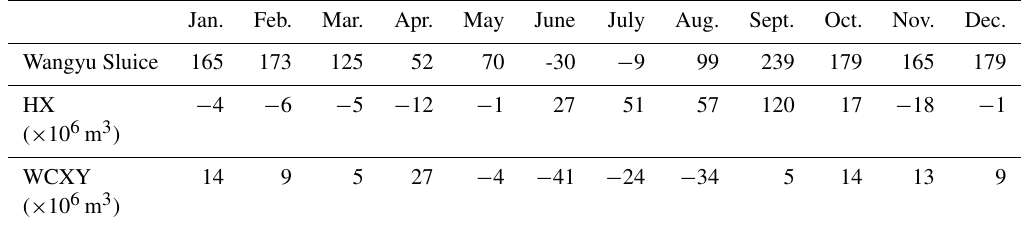
Table 5. Net water diversion and drainage variation along the Yangtze River before 2001 and after 2002.